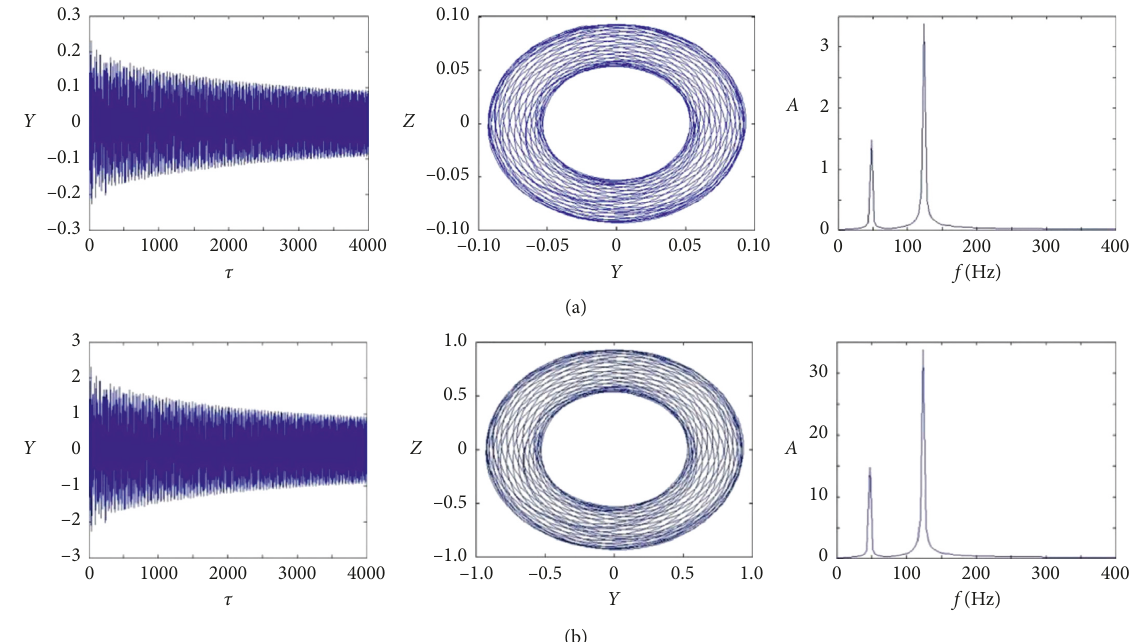
0 . 001 (a) and e 0 . 01 (b) and rotational (cid:29) (cid:29)